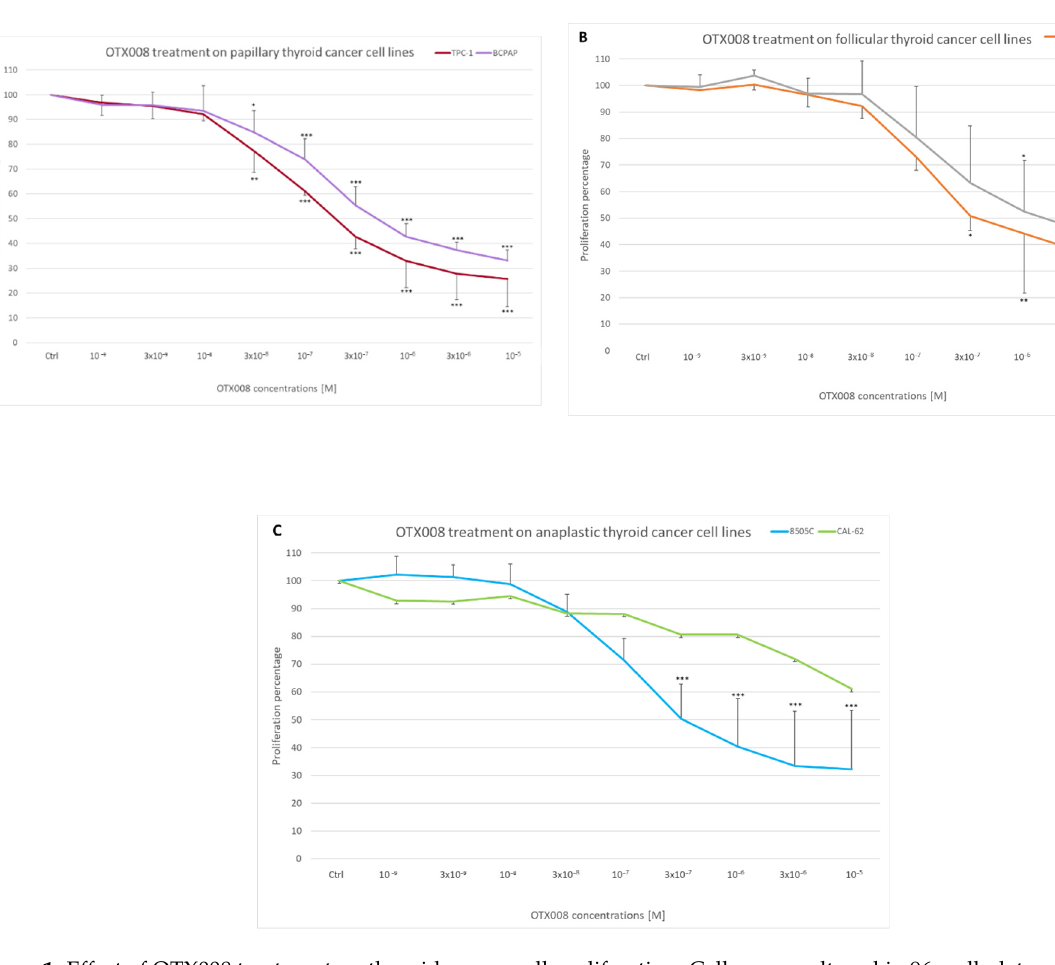
Figure 1. Effect of OTX008 treatment on thyroid cancer cell proliferation. Cells were cultured in 96 well plates and exposed to various concentrations of OTX008 (10 − 9 –10 − 5 M) for 72 h. Cells were fixed in PAF, stained with crystal violet, solubilized with Triton X-100, and the OD of staining was determined at 570 nm. Data present the concentration–response curves of ( A ) papillary thyroid cancer cell lines, ( B ) follicular thyroid cancer lines, and ( C ) anaplastic lines. Control values were normalized at 100% and compared to treatment values. ANOVA and Dunnett post hoc tests were performed to assess significance (* p < 0.05; ** p < 0.01; *** p < 0.001). Table 1. Mutation status (expasy.org) of the six cell lines studied and the IC50 value ( µ M) for